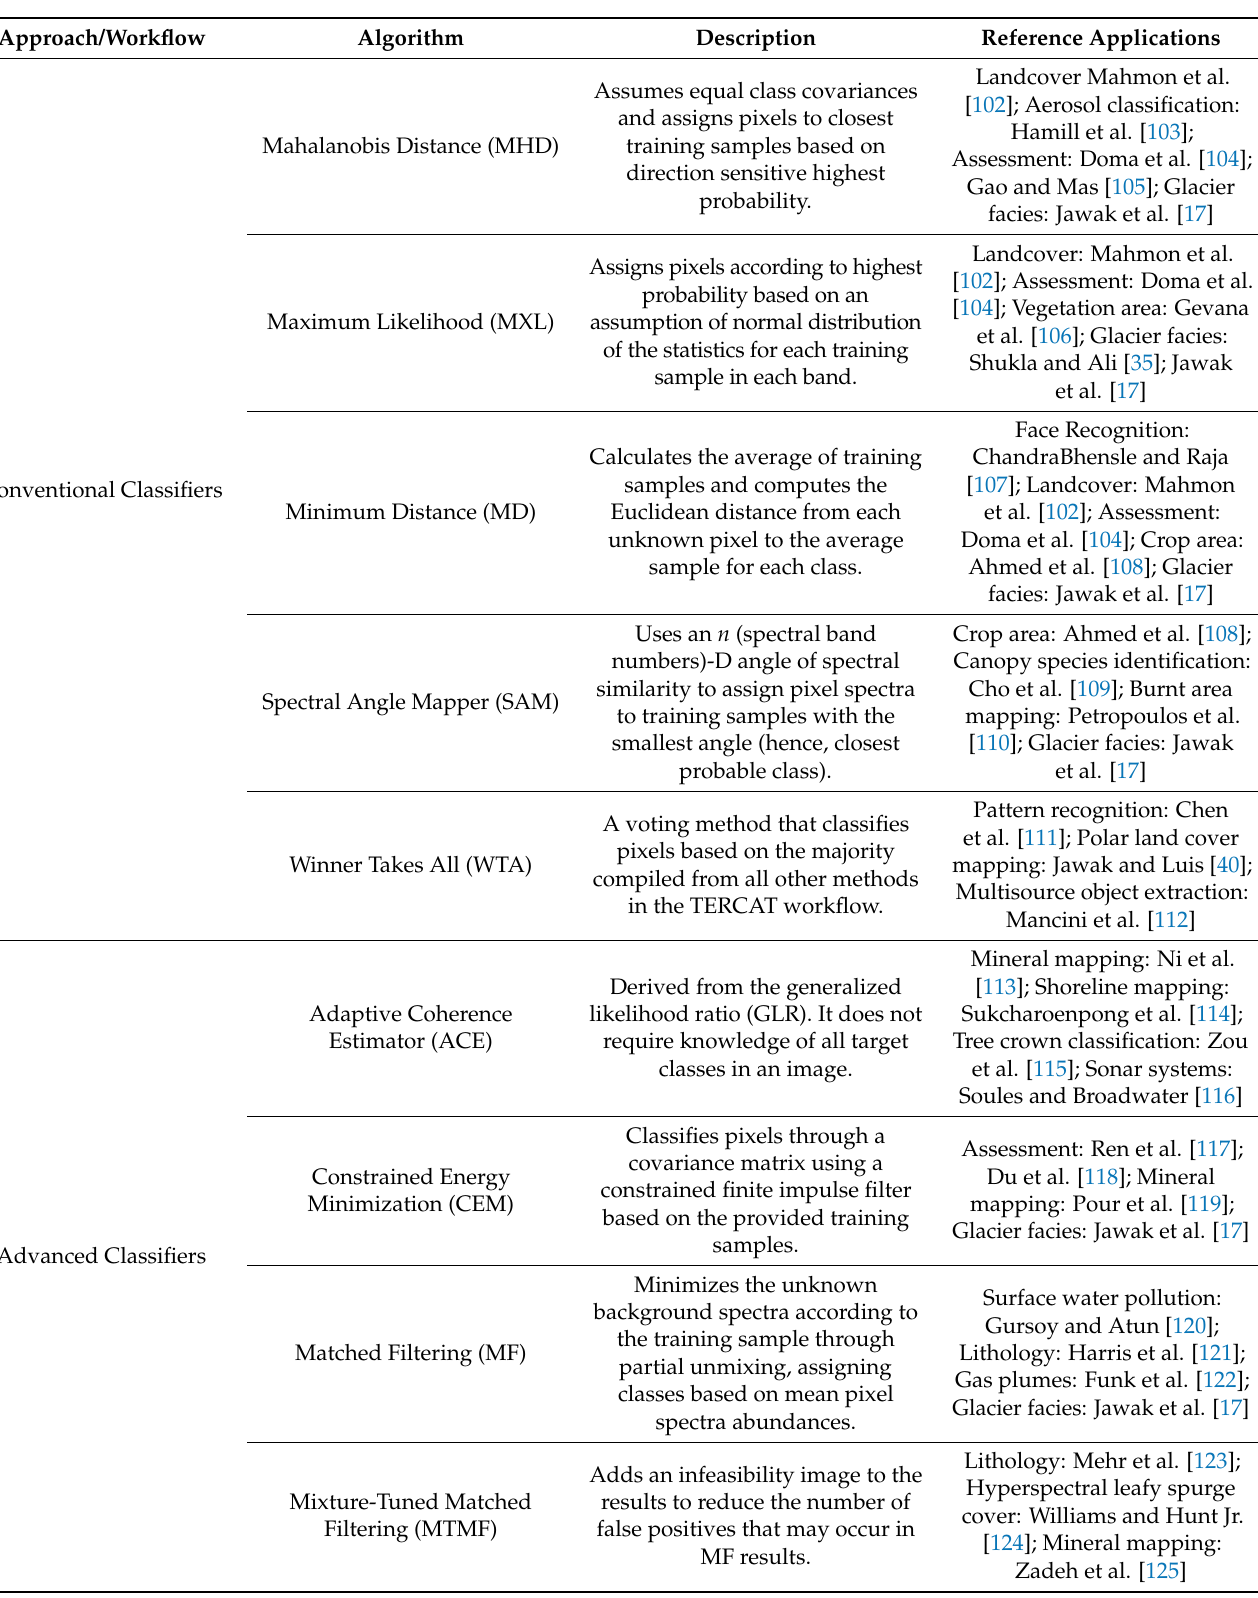
Table 5. Pixel-based classifiers used in this study, their descriptions, and their reference applications. Assessment: wherein different pixel-based methods are assessed for their comparative performance. Descriptions of the classifiers were modified from